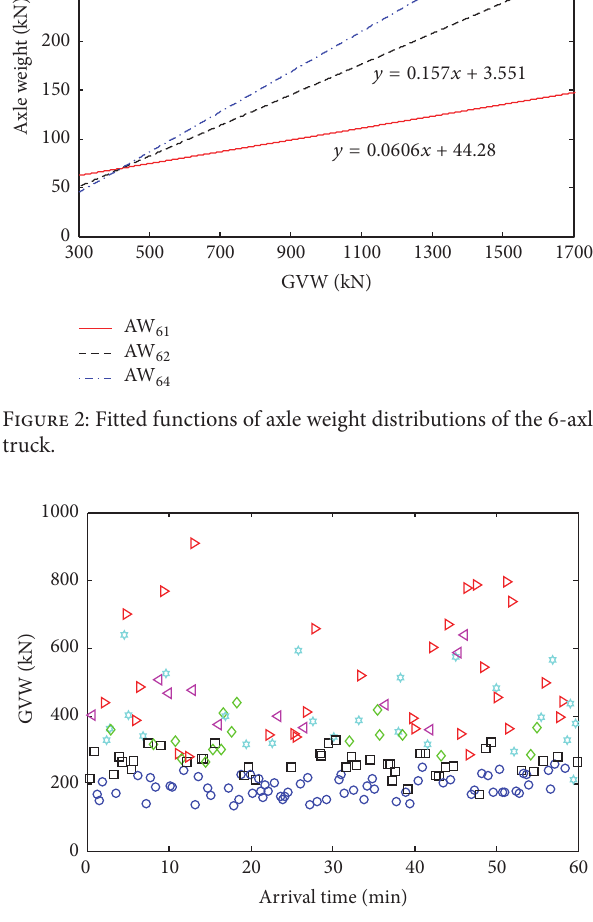
Figure 3: Simulated stochastic traffic load model.